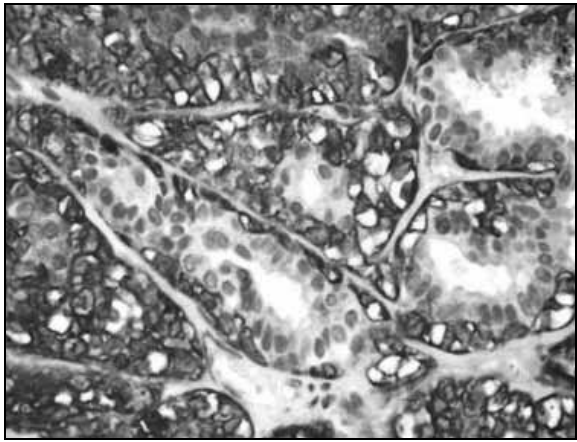
Figure 2 – Positive reaction to the calponin marker in myoepithelial cells (IHQ 400×) IHQ: immunohistochemical.